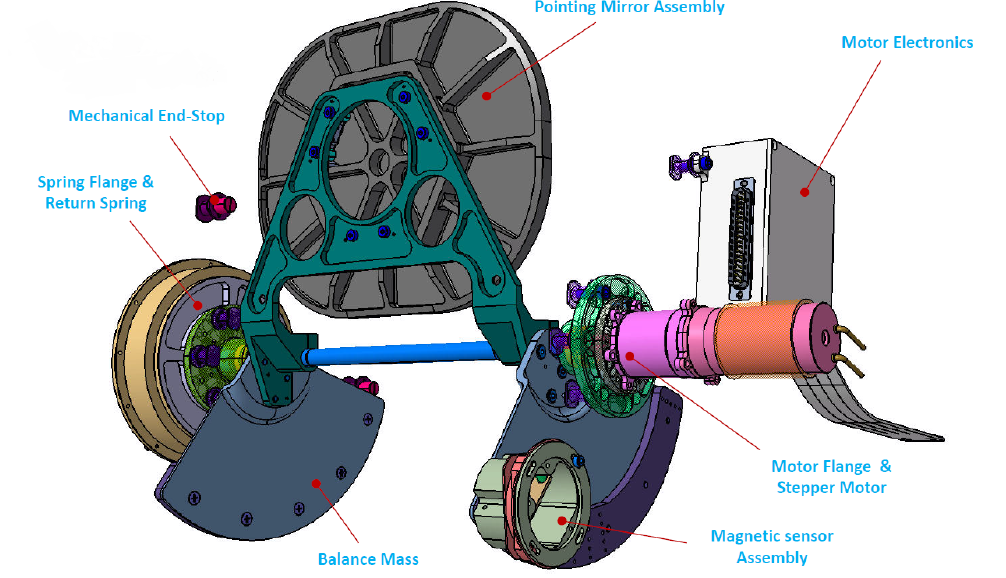
Figure 12. Pointing